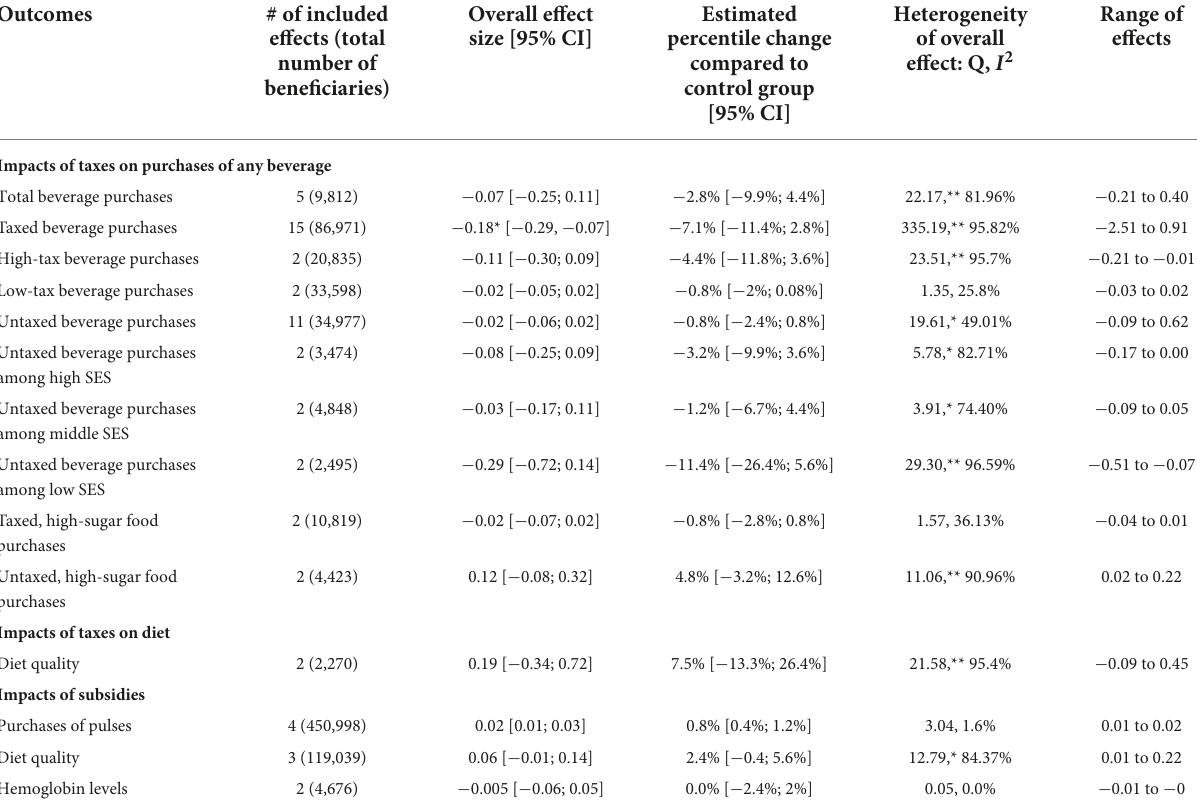
TABLE 6 Results from meta-analysis considering the effects of taxes and subsidies. Outcomes # of included effects (total number of